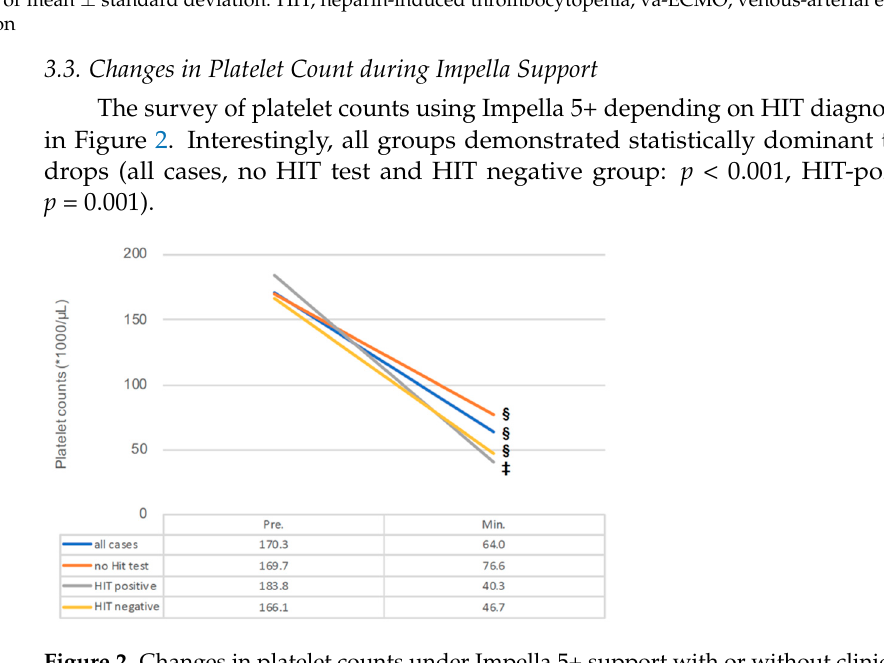
Table 3. HIT-associated clinical features and outcomes.